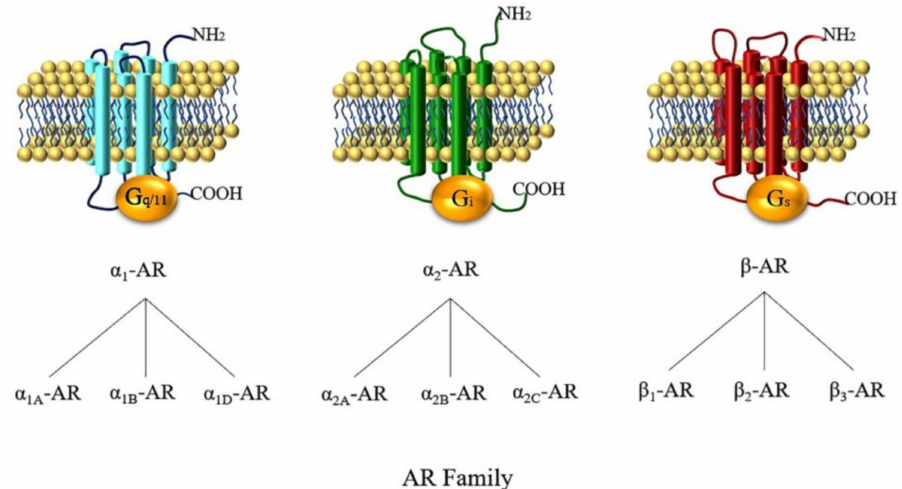
Figure 1. The three adrenoceptor (AR) subfamilies and their subtypes. α 1 -, α 2 -, and β -ARs mainly couple to G q / 11 , G i , and G s proteins, respectively. To be more exact, the α 2A -AR subtype has an unusual dual pharmacological e ff ect by coupling to G i proteins when concentrations of agonists are low and mainly coupling to G s proteins when concentrations are high [43]. β -ARs are mainly coupled to G s proteins and both β 1 - and β 2 -AR are able to switch their G protein-coupling specificity from G s to G i proteins